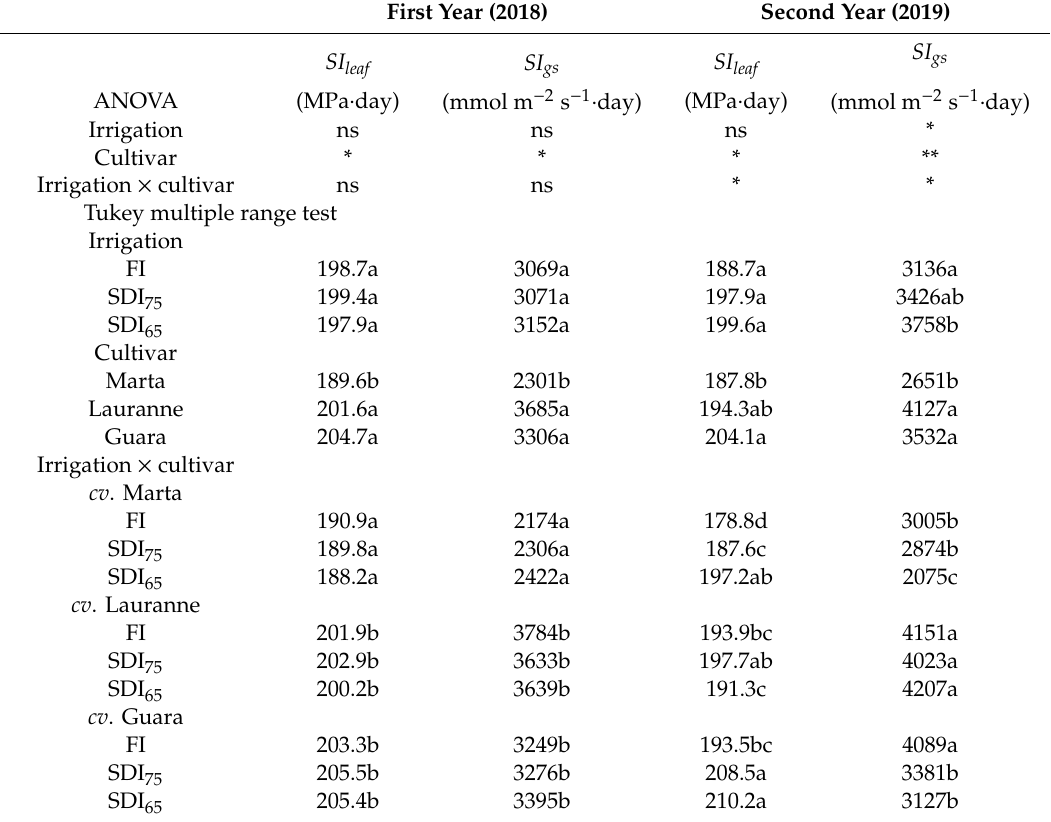
Table 1. E ff ect of deficit irrigation treatment and cultivar on water stress integrals for SI leaf and SI gs .